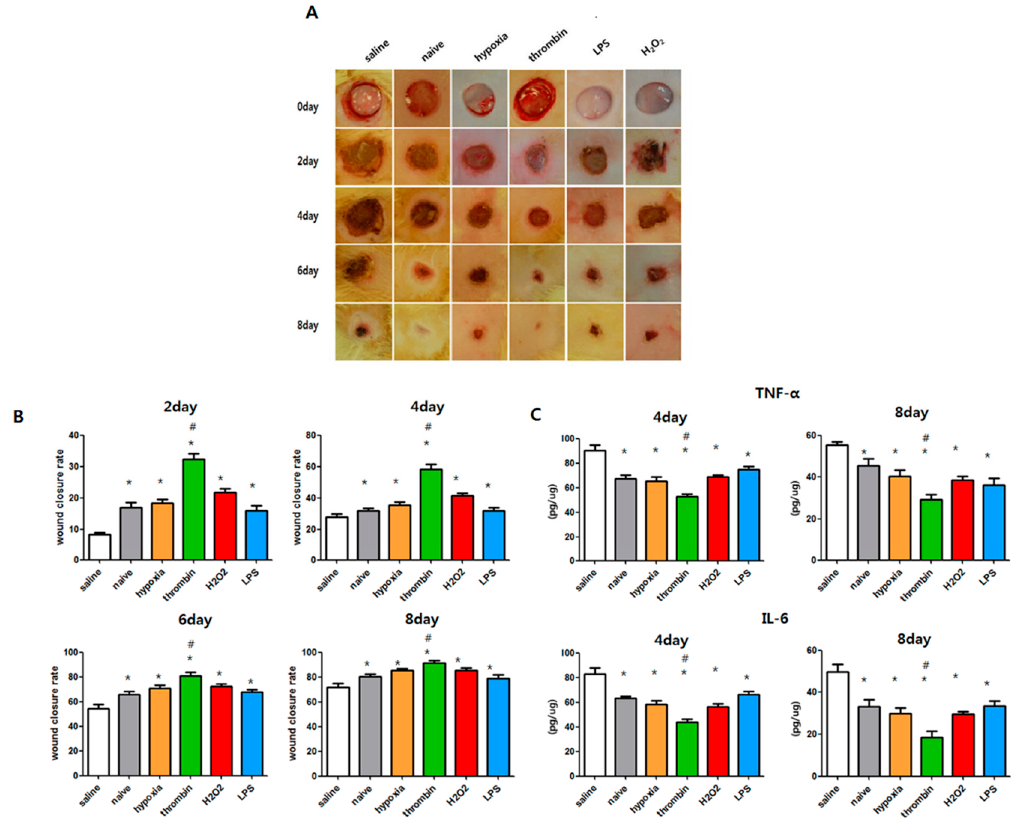
Figure 7. Comparison of wound healing capacity of EVs isolated from the same cell number of MSCs (5 × 10 5 ) in vivo. Punch wounds of animals were treated locally with saline, naive EVs, 10% O2 EVs, thrombin (40 U) EVs, LPS (1 µ g) EVs, or H2O2 (50 µ M) EVs derived from the same number of MSCs. ( A ) Representative serial wound images in vivo and ( B ) the relative wound closure rate (%) after 2, 4, 6, and 8 days of treatment. ( C ) Cytokine analysis for TNF- α and IL-6 β in the homogenate of dissected wound tissues four and eight days after each treatment. Data are presented as mean ± SEM. Statistical analyses were carried out using a One-way Analysis of Variance (ANOVA). The asterisk (*) indicates p < 0.05 compared with saline, and the number sign (#) indicates p < 0.05 compared with the naive EV group ( n = 4 per each analysis).